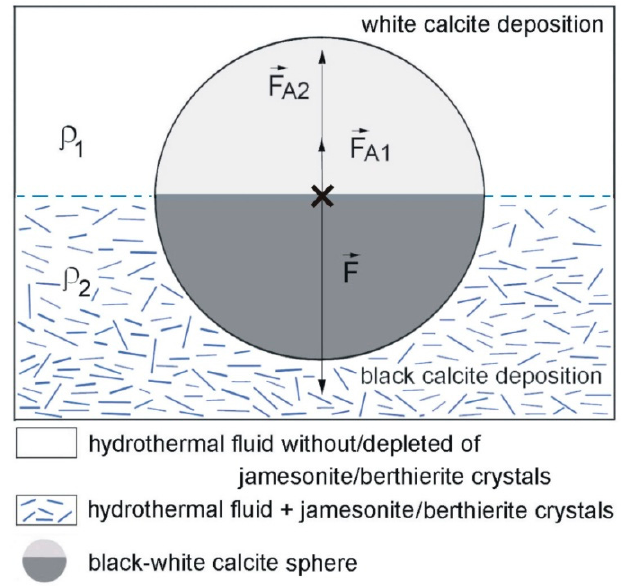
Figure 14. The floatability of ideal half black-half white bicolor calcite sphere at the interface between two hydrothermal fluid layers, the lower one containing gravitationally-concentrated jamesonite needle-like crystals, and the upper one without jamesonite impurities. The physical parameters involved are ρ 1 and ρ 2 —the densities of the upper and the lower hydrothermal fluid layers, respectively; V 1 and V 2 —the volumes of the white (upper), and the black (lower) calcite sections of the sphere; F A1 and F A2 —the buoyant forces exerted on the sphere by the two hydrothermal fluid layers; and F—the gravitational force of the entire sphere. Note the increasing abundance of jamesonite crystals gravitationally concentrated towards the lower part.